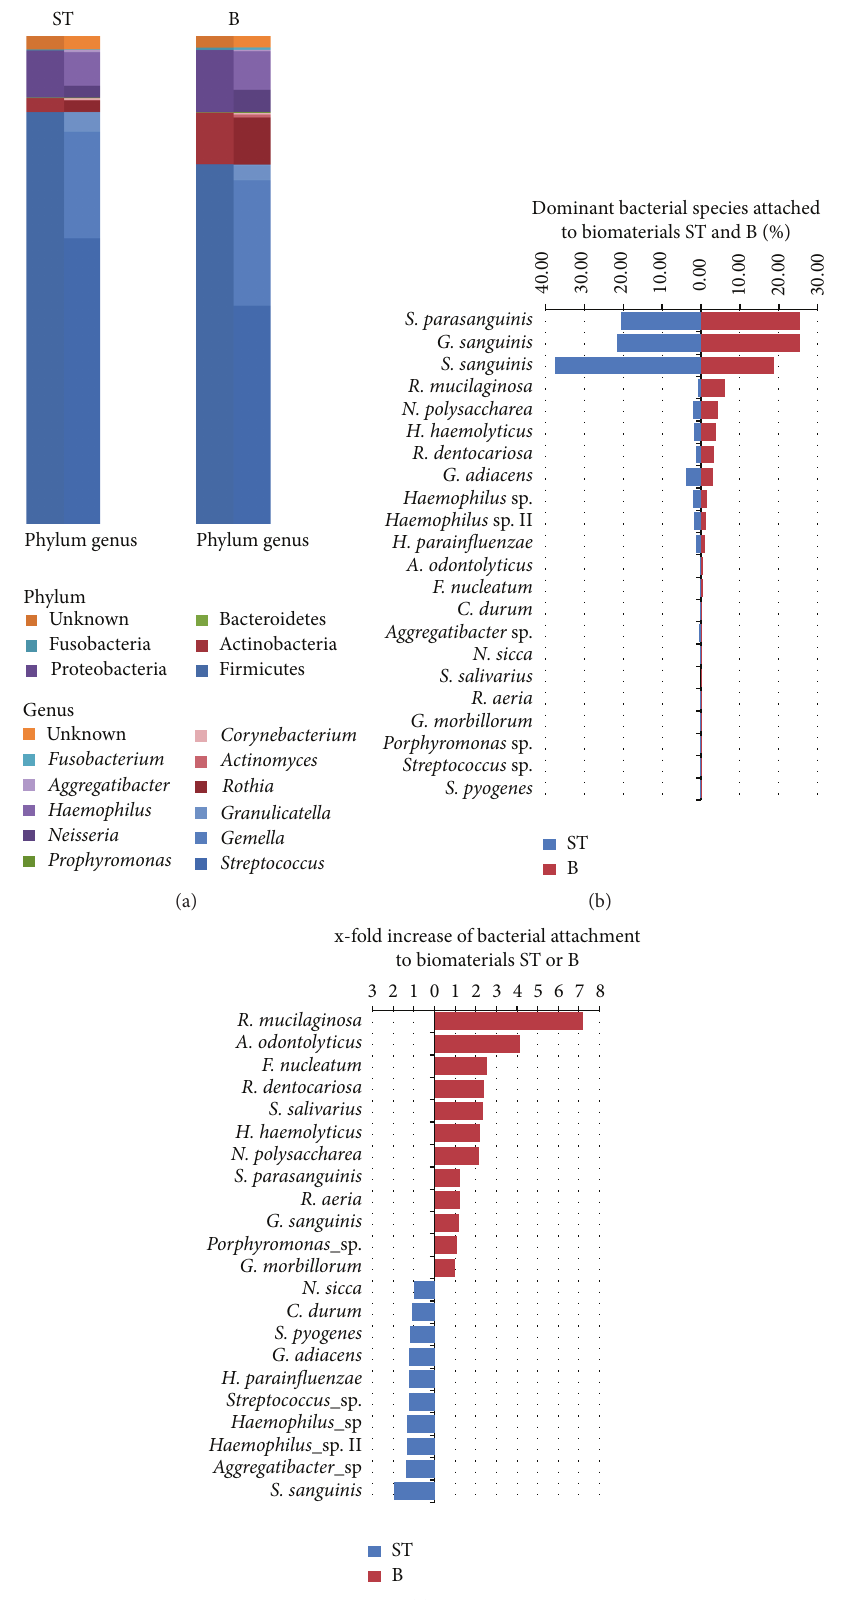
Figure 3: NGS results for materials ST and B for volunteer 1 after 8 h. (a) Phyla and genera, (b) species > 0.1% of microbiota, and (c) species x-fold